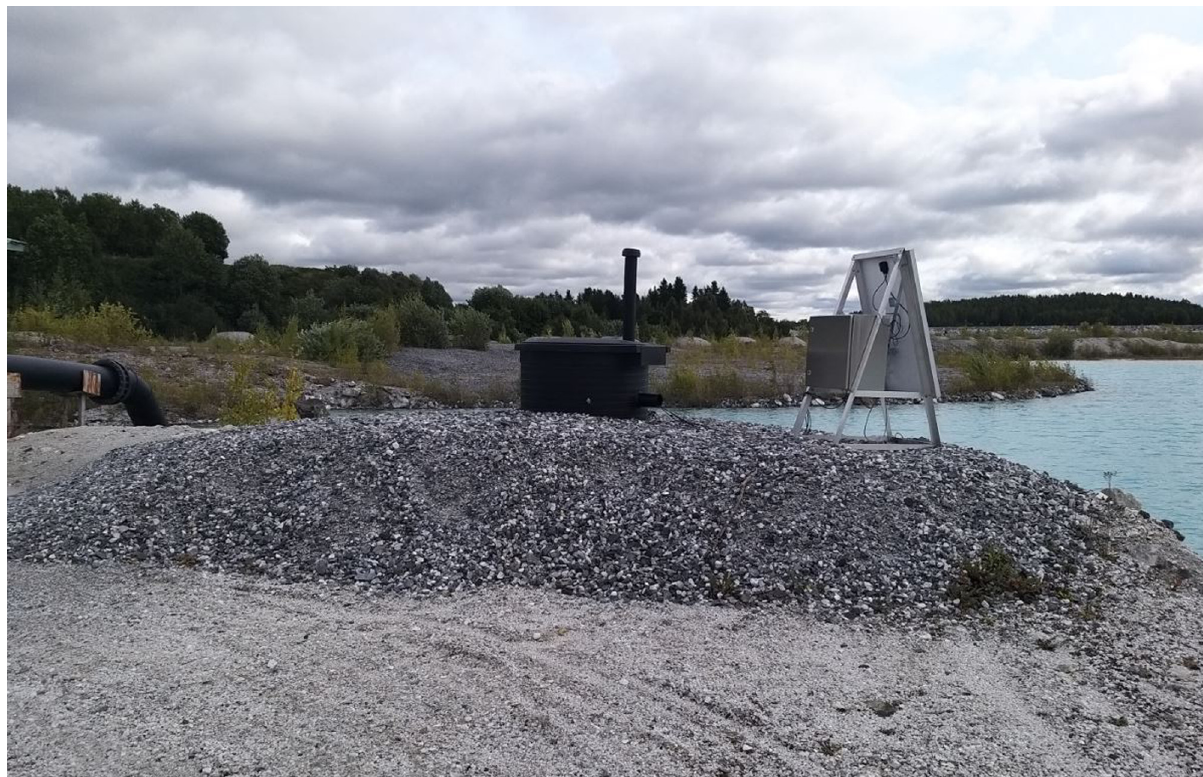
Figure 3: Water quality measurement